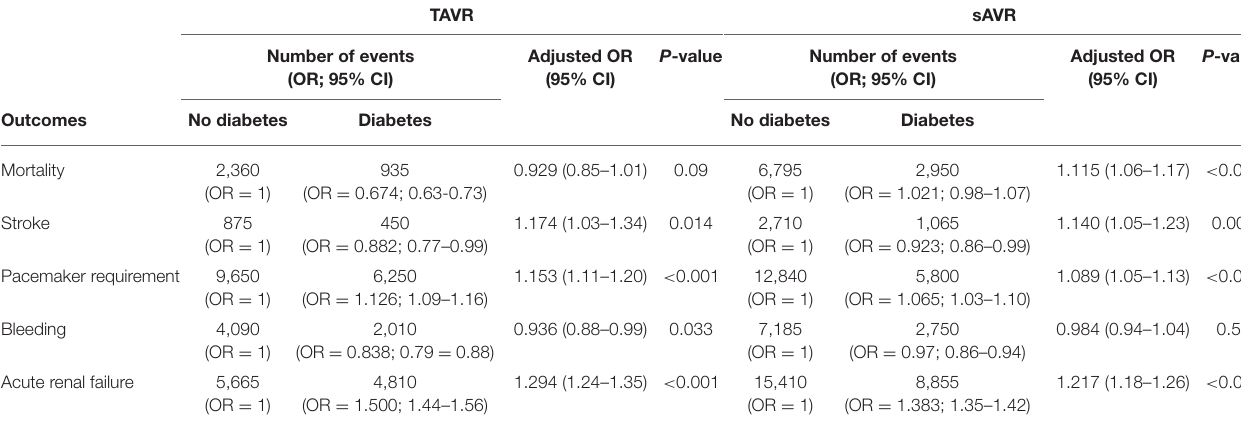
TABLE 3 | Comparison of outcomes of patients undergoing SAVR and TAVR, with and without diabetes.